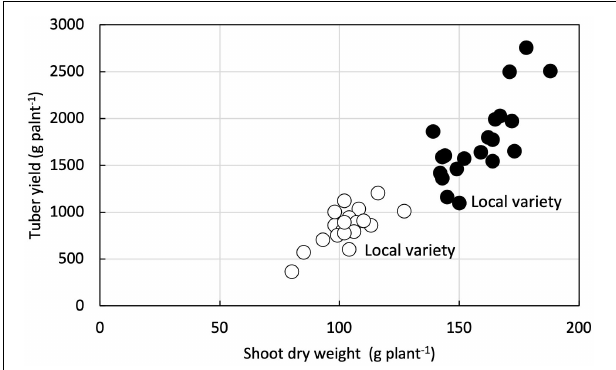
FIGURE 5 | Correlation between soil fertility susceptibility index of shoot dry weight and soil fertility susceptibility index of tuber yield in 21 white Guinea yam genotypes. R means TDr1302 as IITA yam breeding